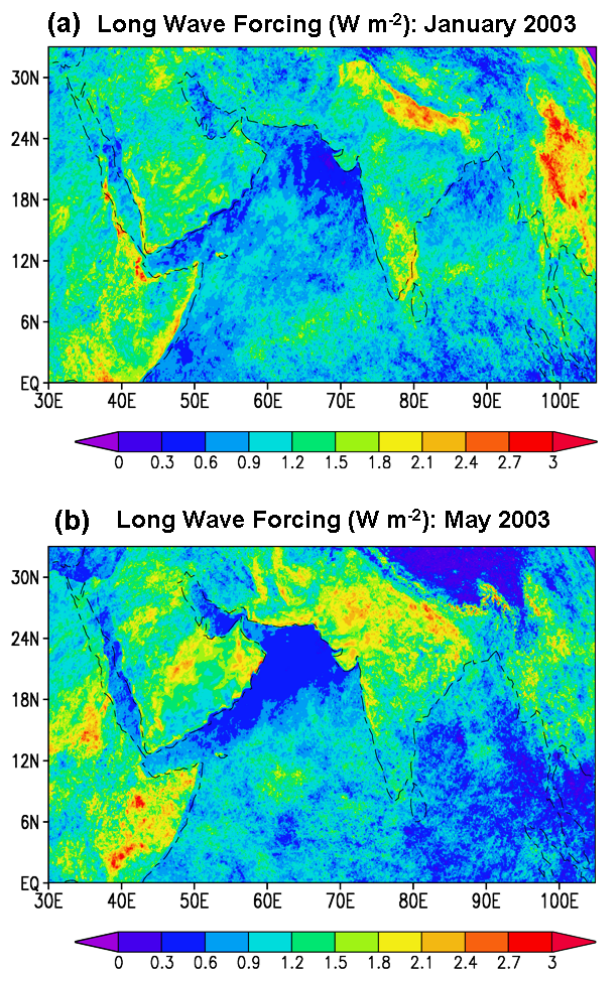
Fig. 5. Regional distribution of long wave dust forcing of over Afro-Asian region (0–35N; 30E–100E) for (a) January 2003 and (b) May